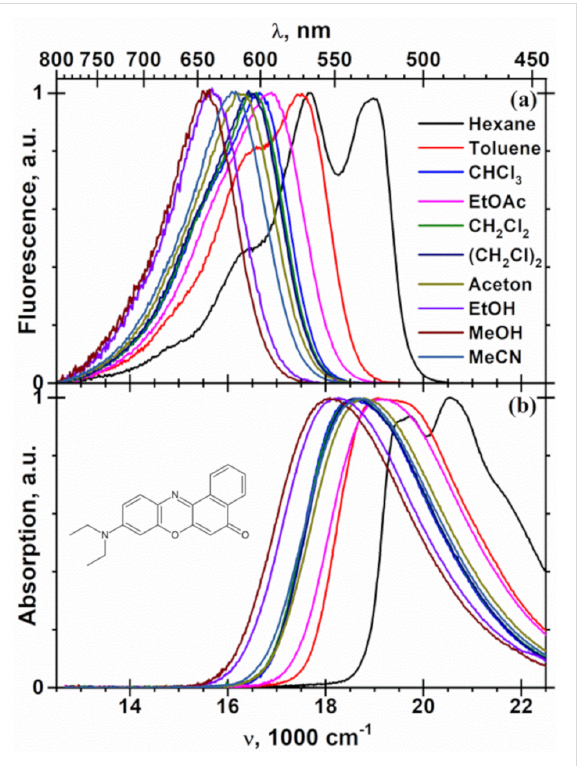
Figure 2: Fluorescence (a) and absorption (b) spectra of NR in sol- vents of different polarity at 25 °C. The solvent marks are hexane for n -hexane, CHCl 3 for chloroform, EtOAc for ethyl acetate, CH 2 Cl 2 for dichloromethane, (CH 2 Cl) 2 for 1,2-dichloroethane, EtOH for ethanol, MeOH for methanol and MeCN for acetonitrile.